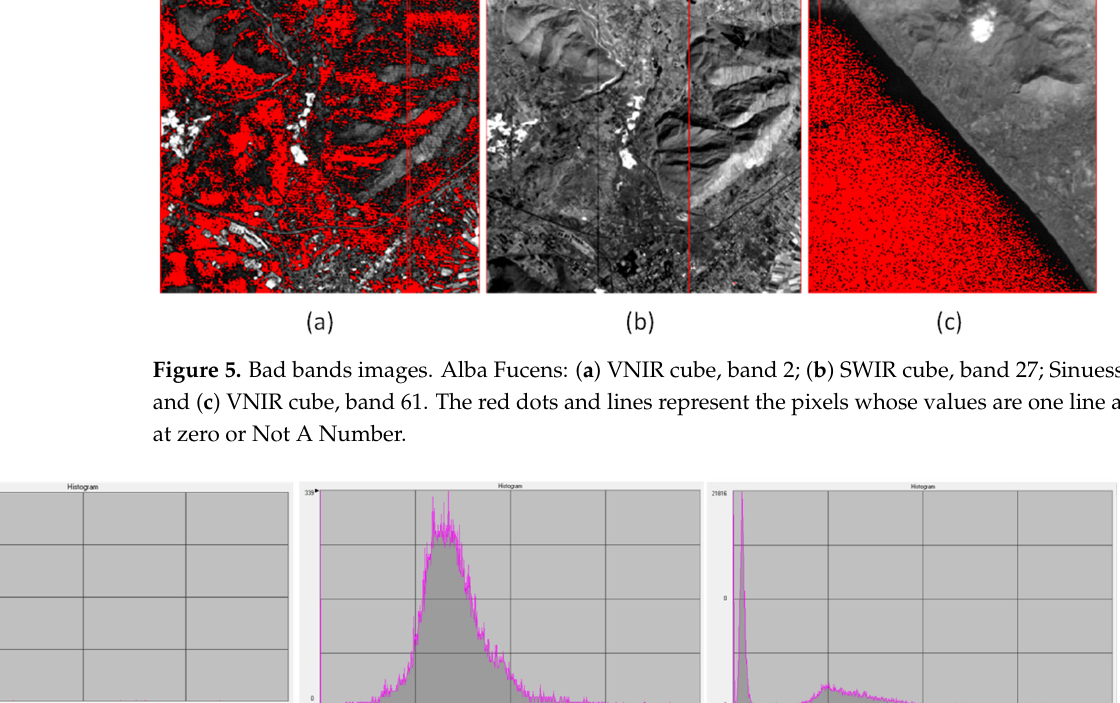
Figure 4. Alba Fucens “good band n. 24”: ( a ) VNIR image; and ( b ) histogram.